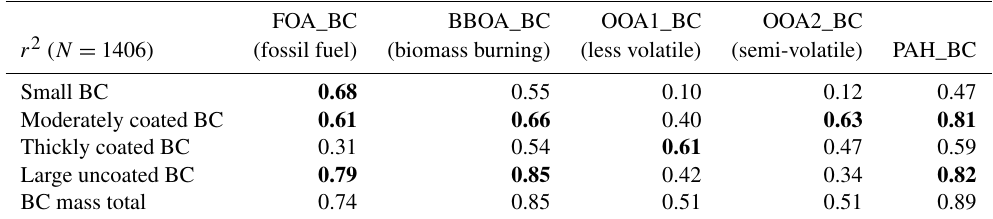
Figure 10. Time series of SP2-separated rBC mass and SP-AMS separated C x mass by PMF analysis. Table 1. Pearson’s correlation coefficients between the time series of SP2 and SP-AMS segregated rBC mass and PAH. The correlations with Pearson’s r 2 > 0.6 are in bold font. All correlations are significant at the 0.01 level